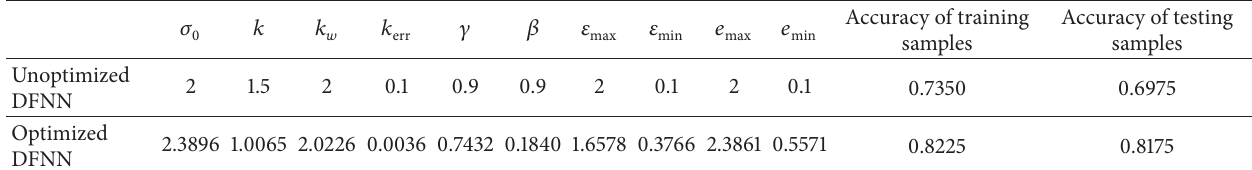
Table 2: The prediction accuracies of two